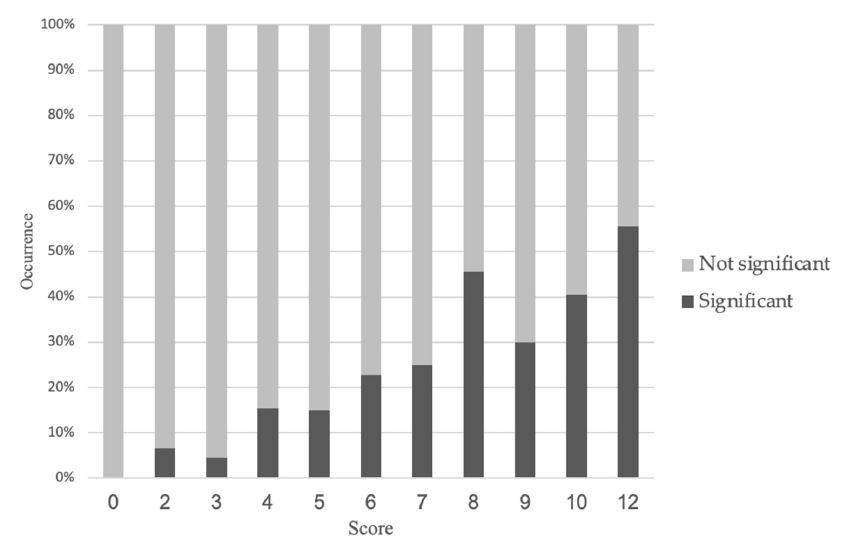
Figure 2 shoed observed occurrence of significant stenosis according to the new score. Higher score tent to had higher proportion of the severe narrowing on coronary arteries. Figure 3 were ROC curve of the new model, and AUC was 0.782 (95% CI 0.742– 0.822), p < 0.001. Cut-off value of 5 point which was calculated by using the Youden index showed 86.6% of sensitivity and 56.4% of specificity (Table 3).